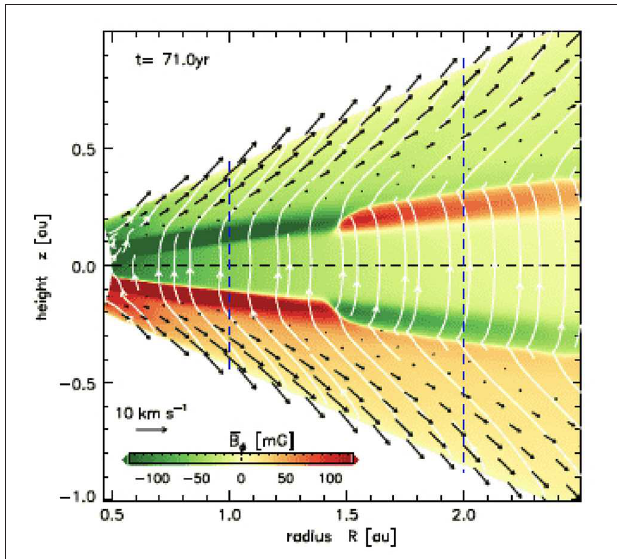
FIGURE 9 | Plot of the toroidal field (color) with peak values of a few hundred mG. The projected magnetic field lines (white) and velocity vectors (black) are indicated as is the position of the wind base (dot–dash). From Gressel et al. (2015) reproduced with permission c (cid:13)